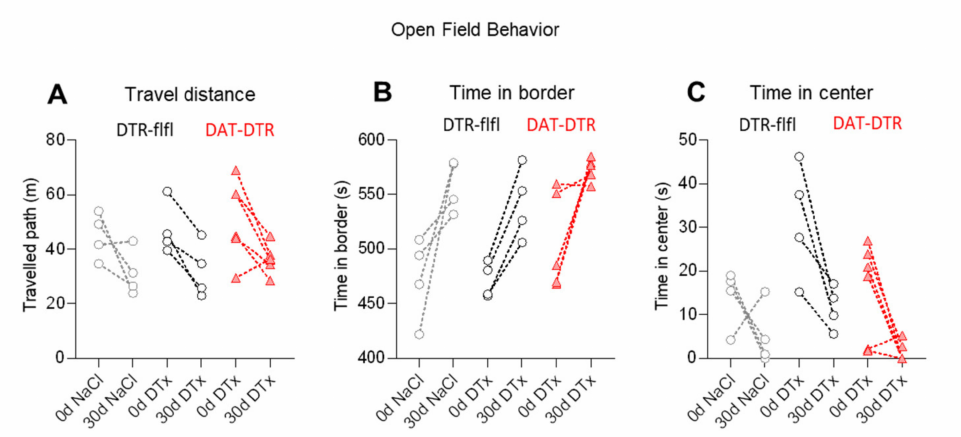
Figure 5. Paired analysis of test-retest behavior in the open field test. ( A – C ) Paired analysis of test- retest OFT behavior of individual mice was used to assess learning. Data were compared with 2-way ANOVA and revealed a significant effect of time (i.e., test versus retest) but not of the between-subject factor group. Sample sizes n = 4–6 per group.